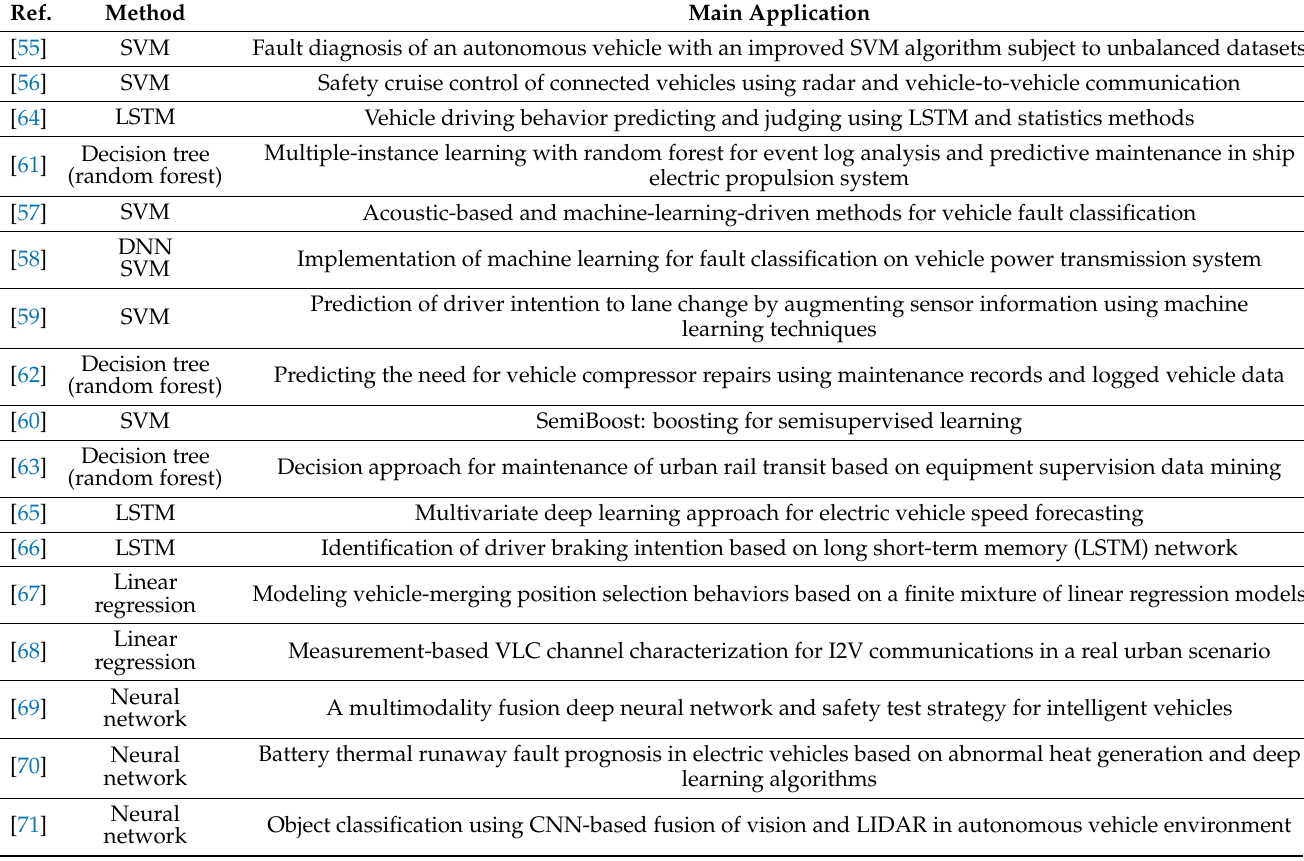
Table 2. Supervised